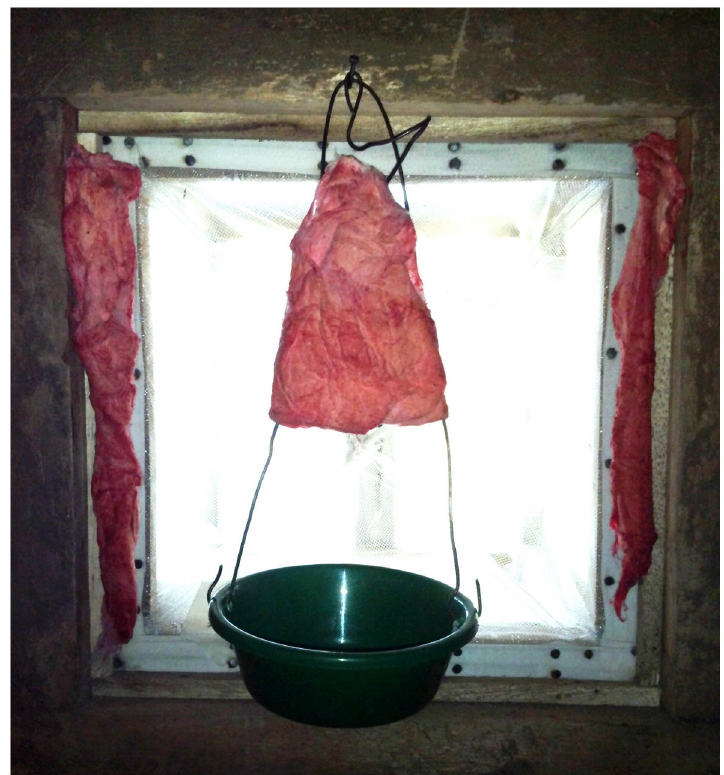
Figure 2. ATSB station positioning near window